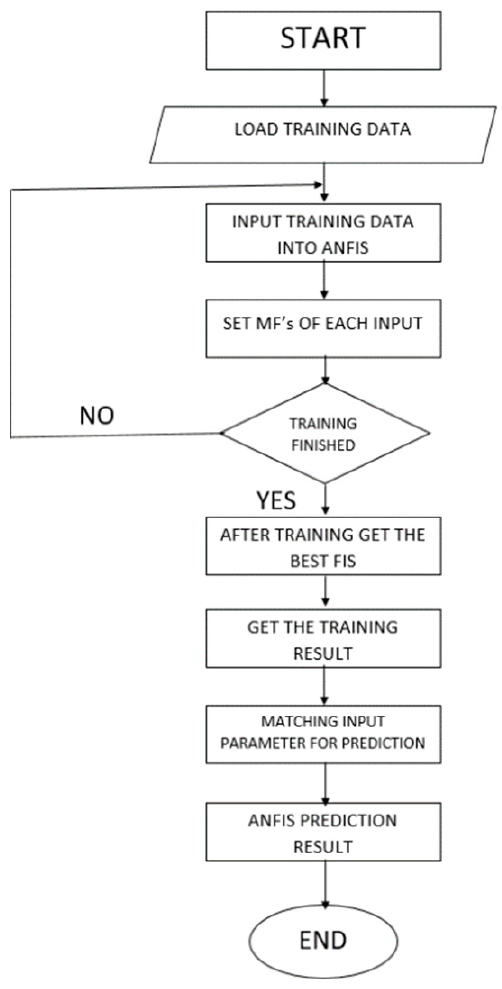
Figure 18. Flow chart of ANFIS control technique.